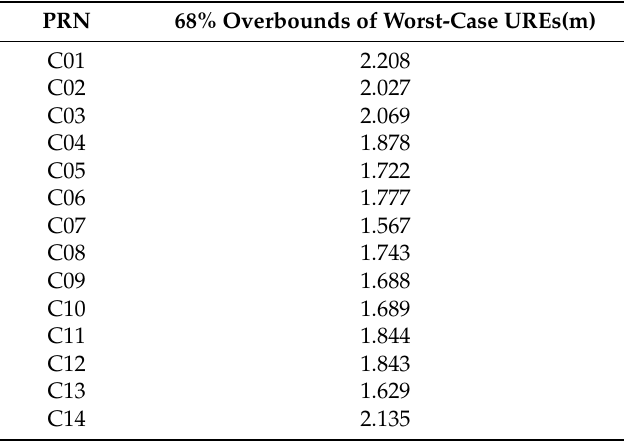
Table 1. Worst-case UREs: 68%.